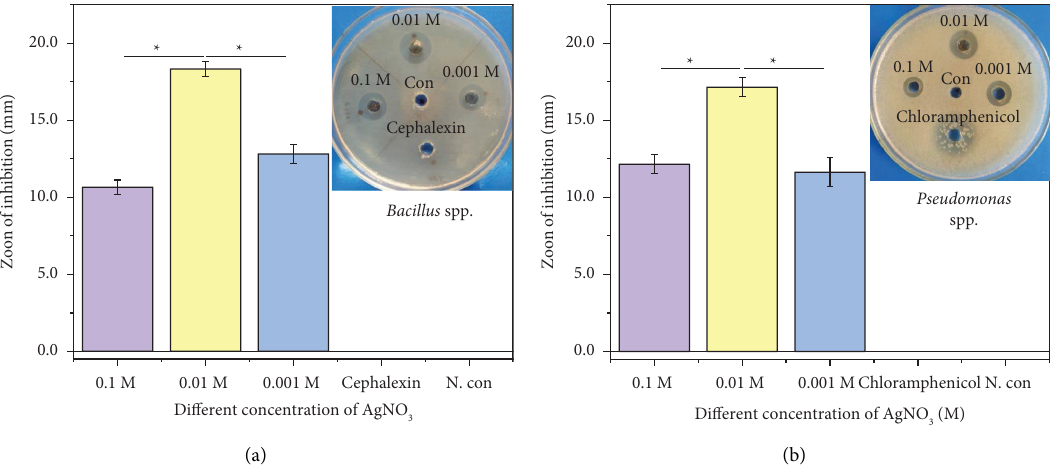
Figure 9: Images showing zone of inhibition of Ag-NPs in comparison with resistance antibiotics: (a) Bacillus spp. and (b) Pseudomonas spp. ( ∗ remarked the signifcant level of zone of